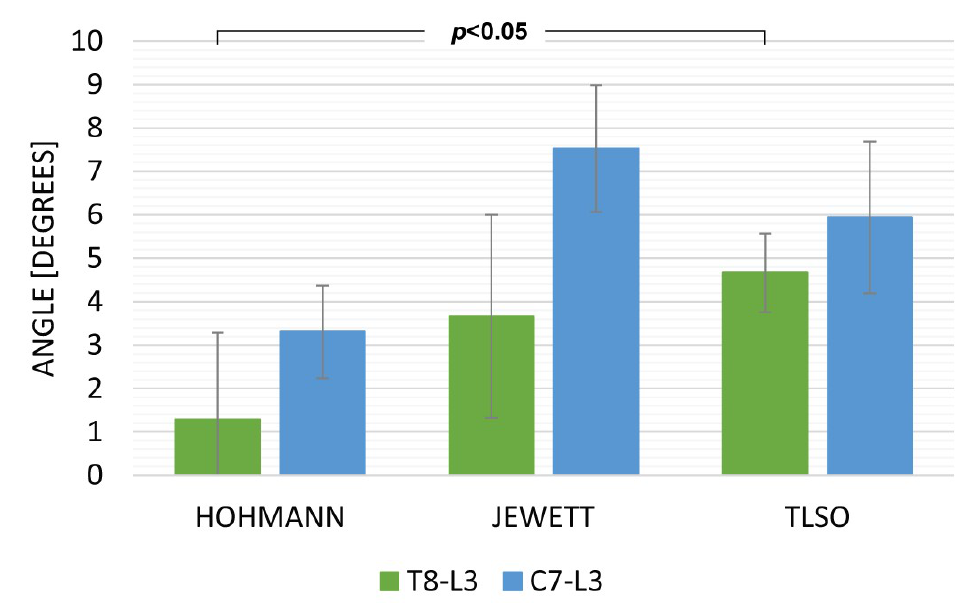
Figure 5. The maximum sagittal inclination while lifting an object from the floor.